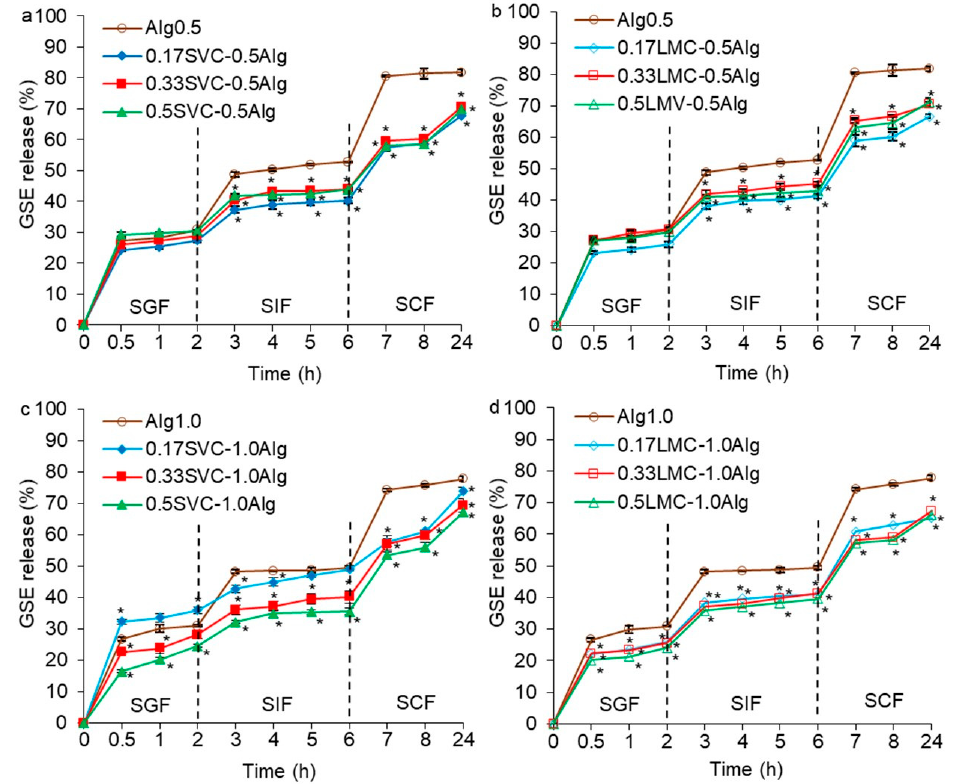
Figure 7. The release of GSE in vitro from hydrogels based on 0.5% alginate and SVC cells ( a ), 0.5% alginate and LMC cells ( b ), 1.0% alginate and SVC cells ( c ), 1.0% alginate and LMC cells ( d ) in the simulated gastric, intestinal, and colonic (SGF, SIF, and SCF, respectively) fluids. The data are presented as the mean ± S.D., n = 6. * p < 0.05 vs. 0.5 or 1.0% alginate.